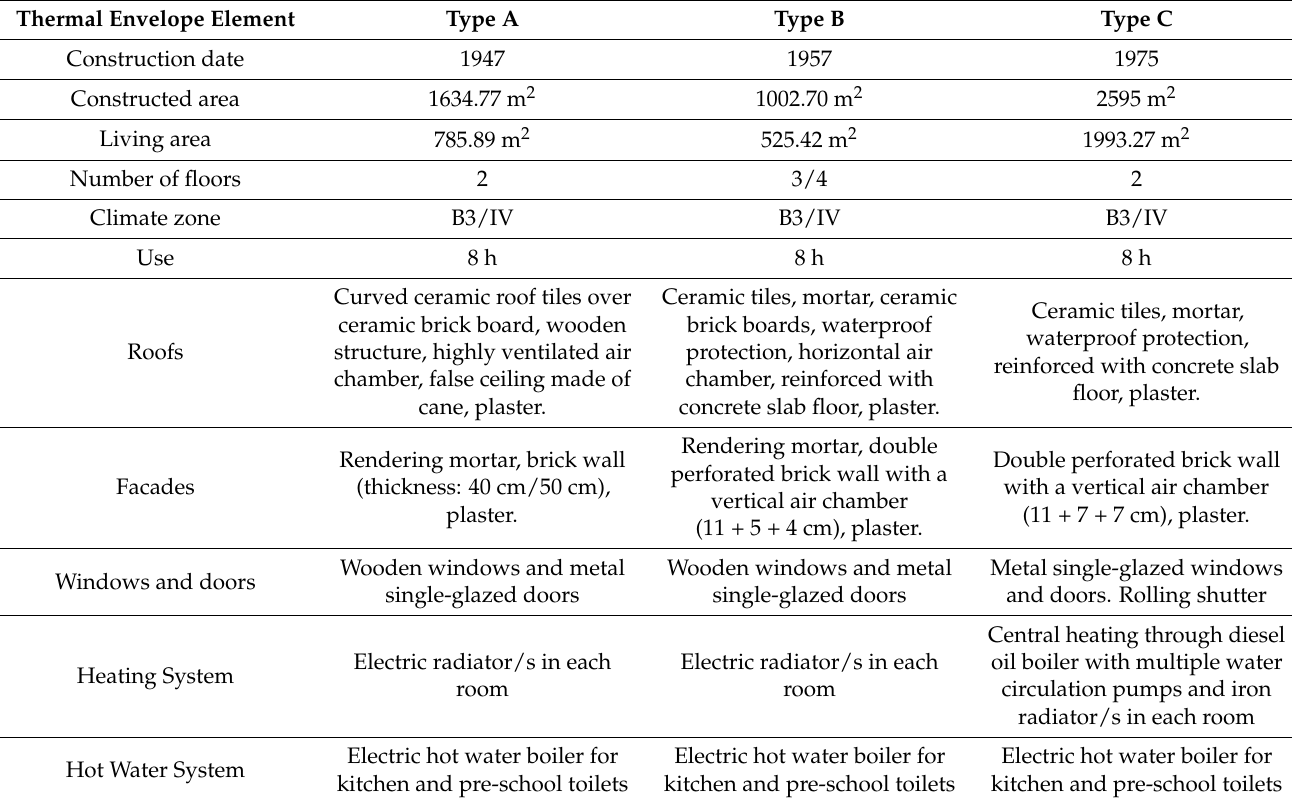
Table 1. Specifications and characteristics of building types.